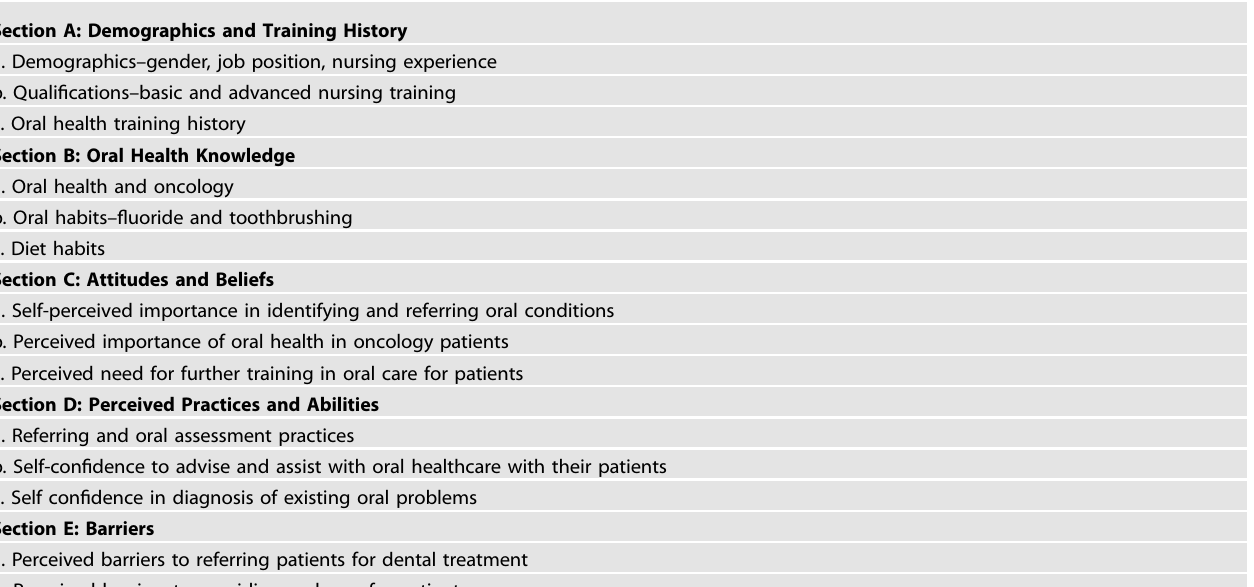
Table 1. Key aspects explored by survey